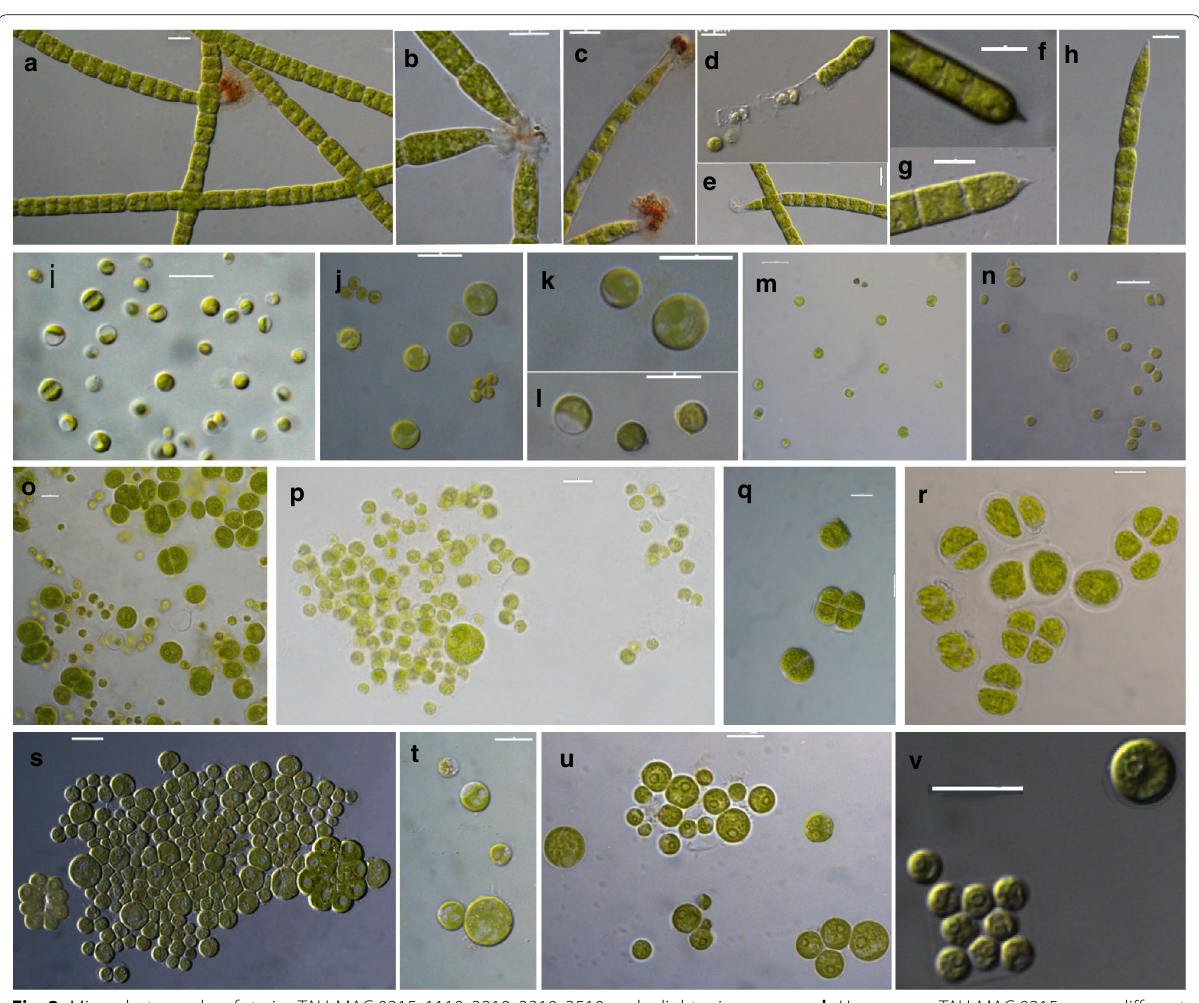
Fig. 2 Microphotographs of strains TAU-MAC 0215, 1110, 3210, 3310, 3510 under light microscopy. a – h Uronema sp. TAU-MAC 0215; a – c , e different morphologies of the holdfast, d release of aplanospores, f – h filaments with apical cells showing alterative degree of tapering. i–k Chlorella vulgaris TAU-MAC 1110 and l – n TAU-MAC 3210; demonstrating sporangium with two autospores, young and mature cells with one big pyrenoid. o – r Spongiosarcinopsis sp. TAU-MAC 3310; o , p young vegetative cells derived from zoospores or aplanospores, aplanospores and aplanosporangium, q , r mature vegetative cells arranged in dyad and tetrad aggregation. s – v Chlamydomonadales sp. TAU-MAC 3510; s – u mature vegetative cells form tight aggregations, v